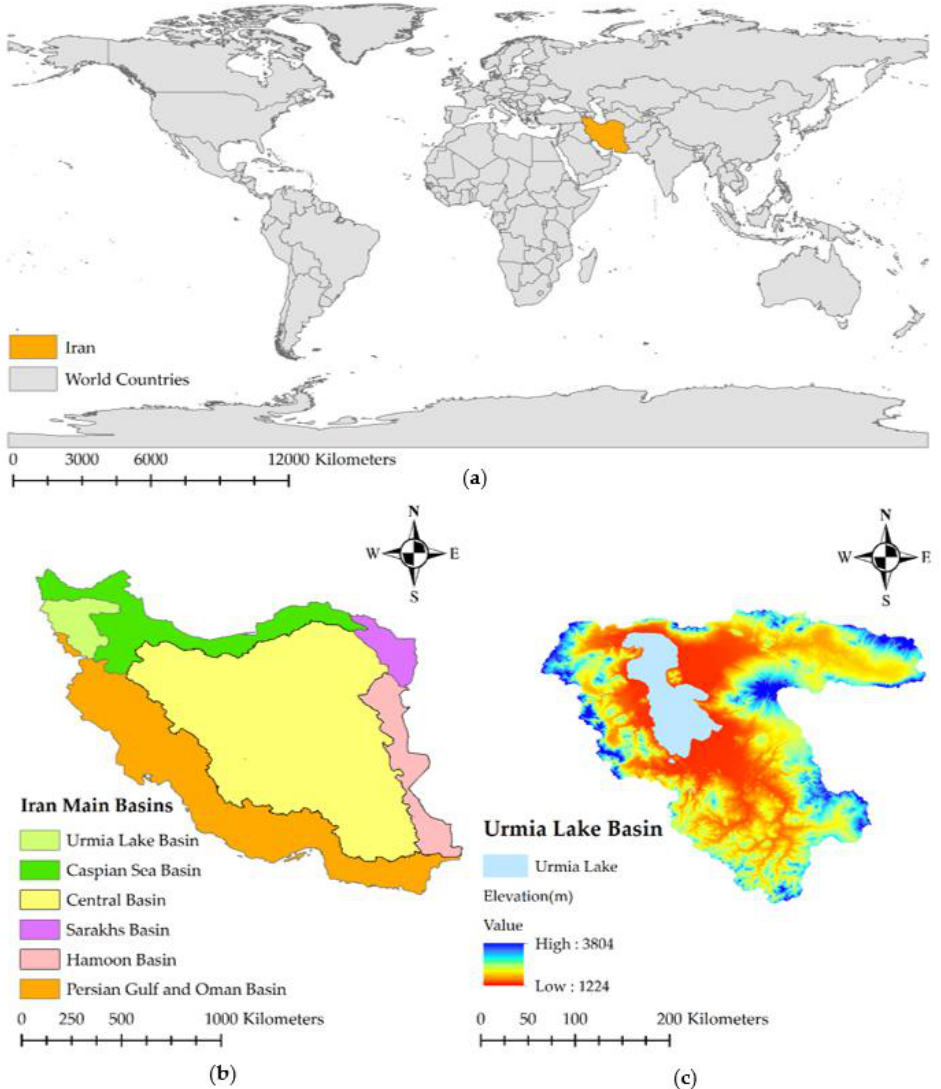
Figure 2. ( a ) Iran on the world map; ( b ) Urmia Lake Basin among Iran’s Main Basins; ( c ) Urmia Lake Basin.